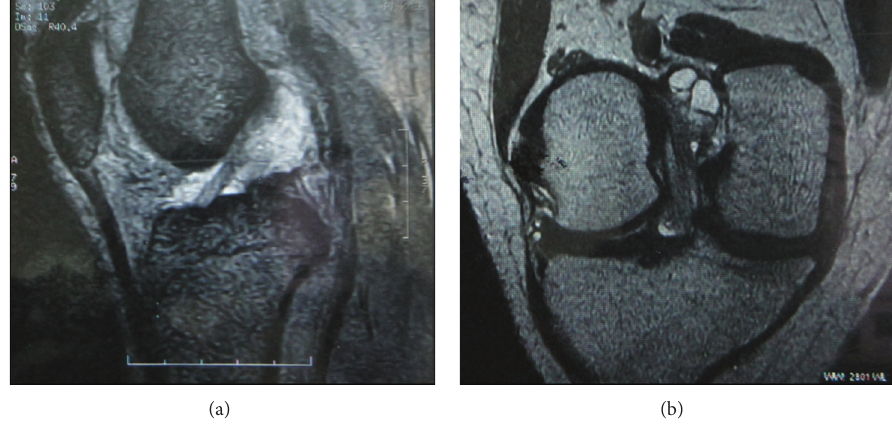
Figure 1: MRI images of ACL ganglion cysts.